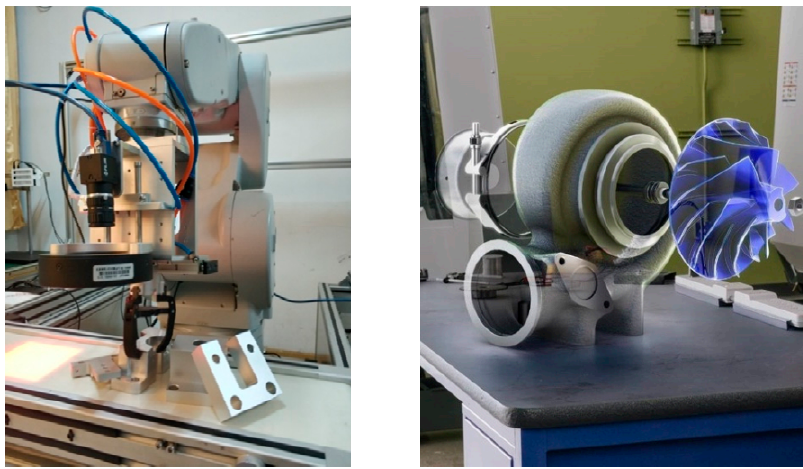
Figure 1. 6D pose estimation applied in bin picking and augmented